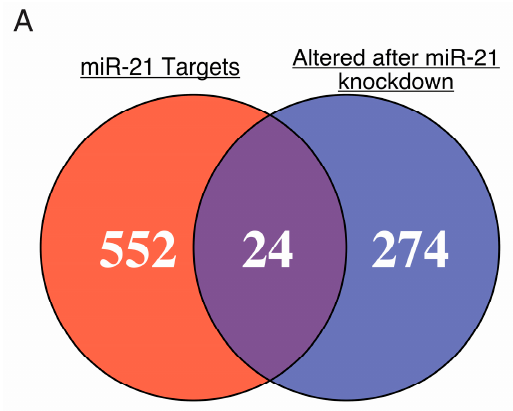
Figure 5. Gene identifiers from transcripts in association with miR-21 identified by Argonaute-CLIP were matched to genes dysregulated in SK-Hep-1 cells after treatment with anti-miR-21 (GSE65892) [33]. The 24 common genes were considered potential miR-21 targets.